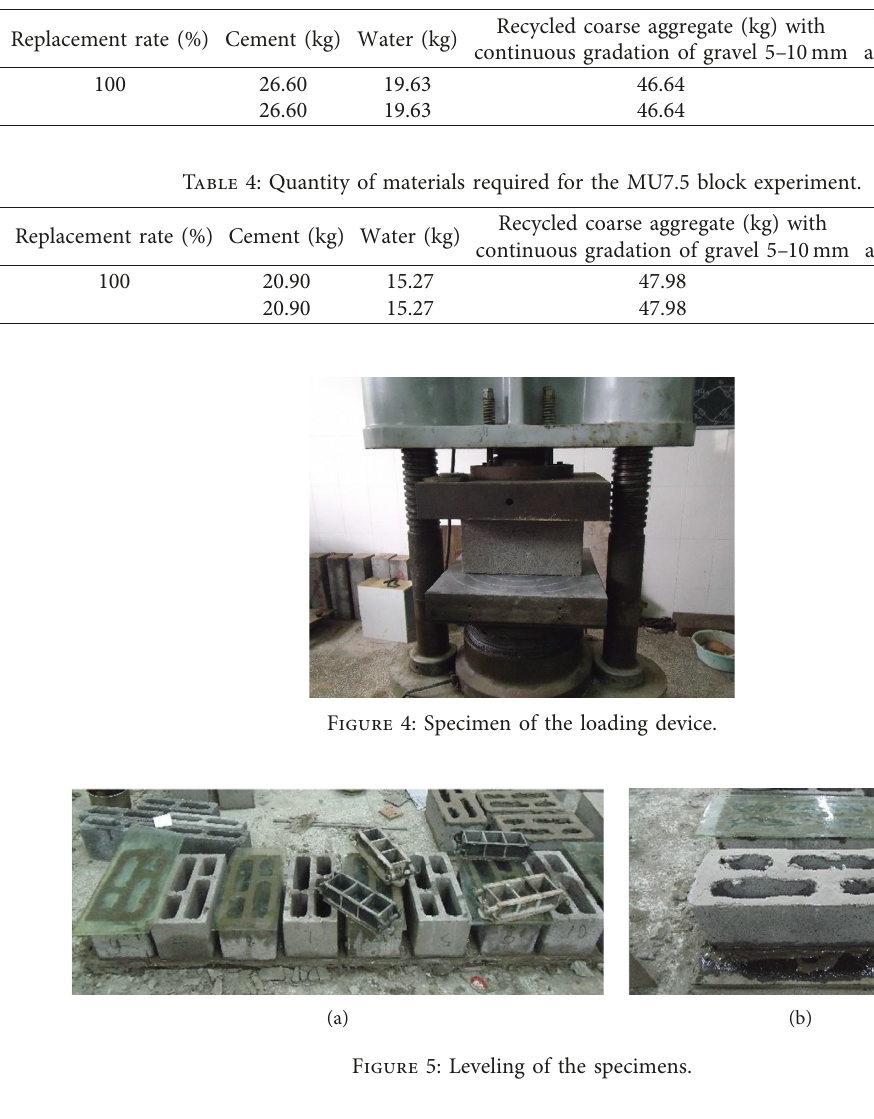
Table 3: Quantity of materials required for the MU10 block experiment.